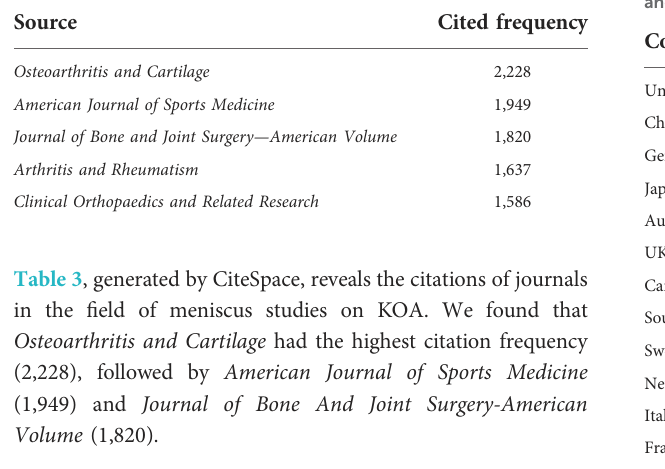
TABLE 3 The most citations of journals in meniscus with